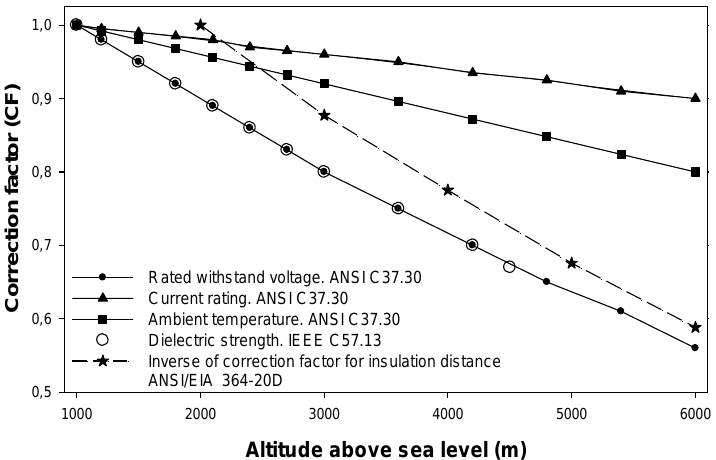
Figure 5. Altitude correction factors according to the ANSI C37.30 standard [39], dielectric strength correction factor according to the IEEE C57.13 standard [38] and correction factors for insulation distances proposed by the ANSI/EIA 364-20D standard [68].